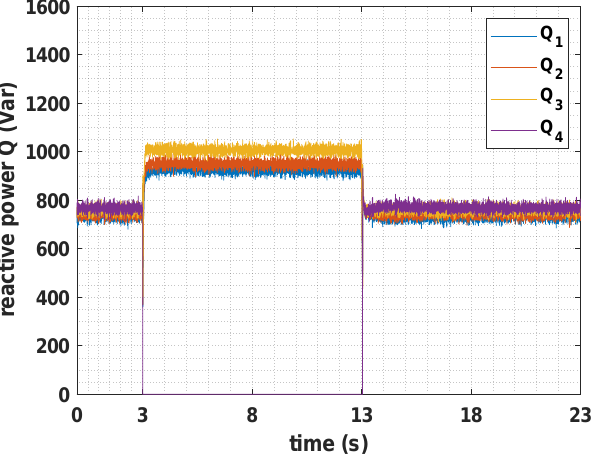
Figure 11. Response of reactive power for event-triggered mechanism in Case